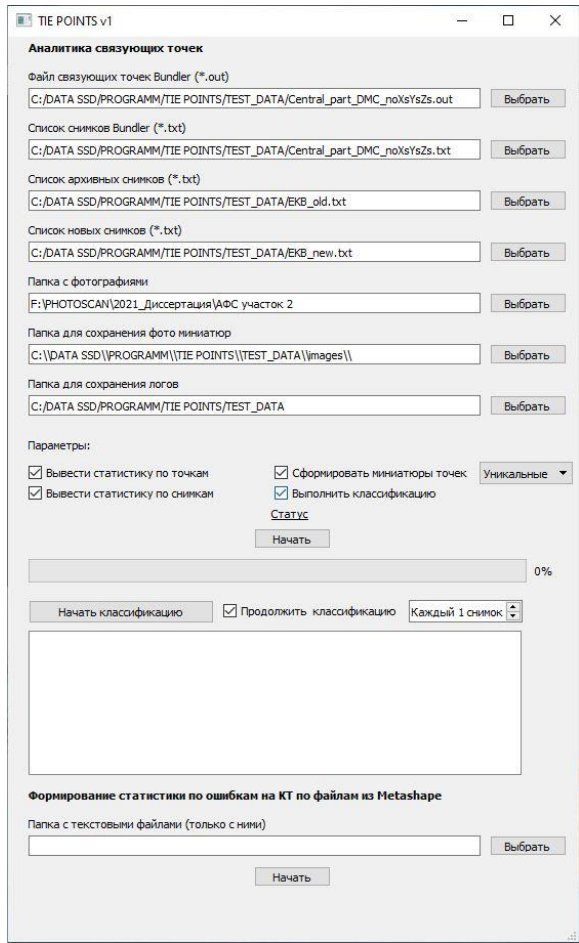
Figure 8. Tie points analyzer program interface.